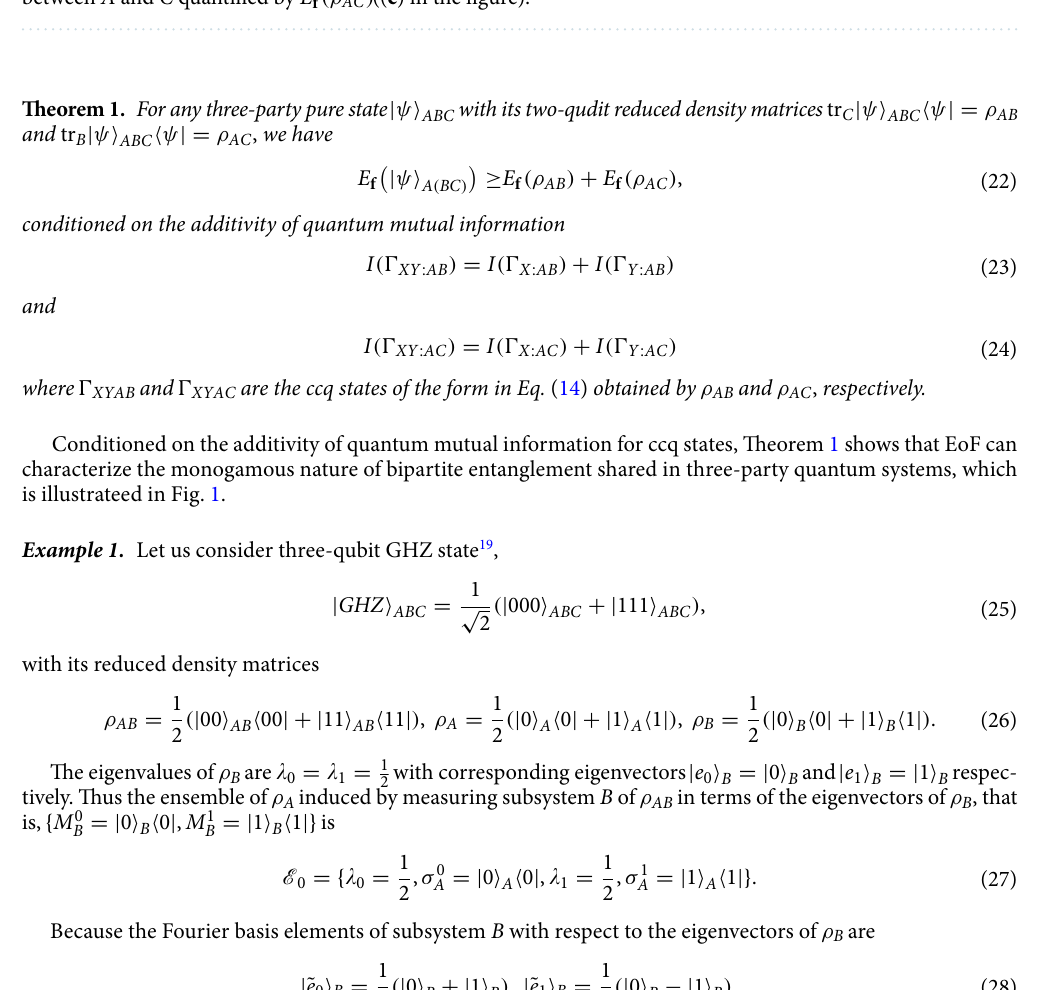
ψ (( a ) in the figure) bounds the A ( BC ) | � (cid:31) (cid:30)